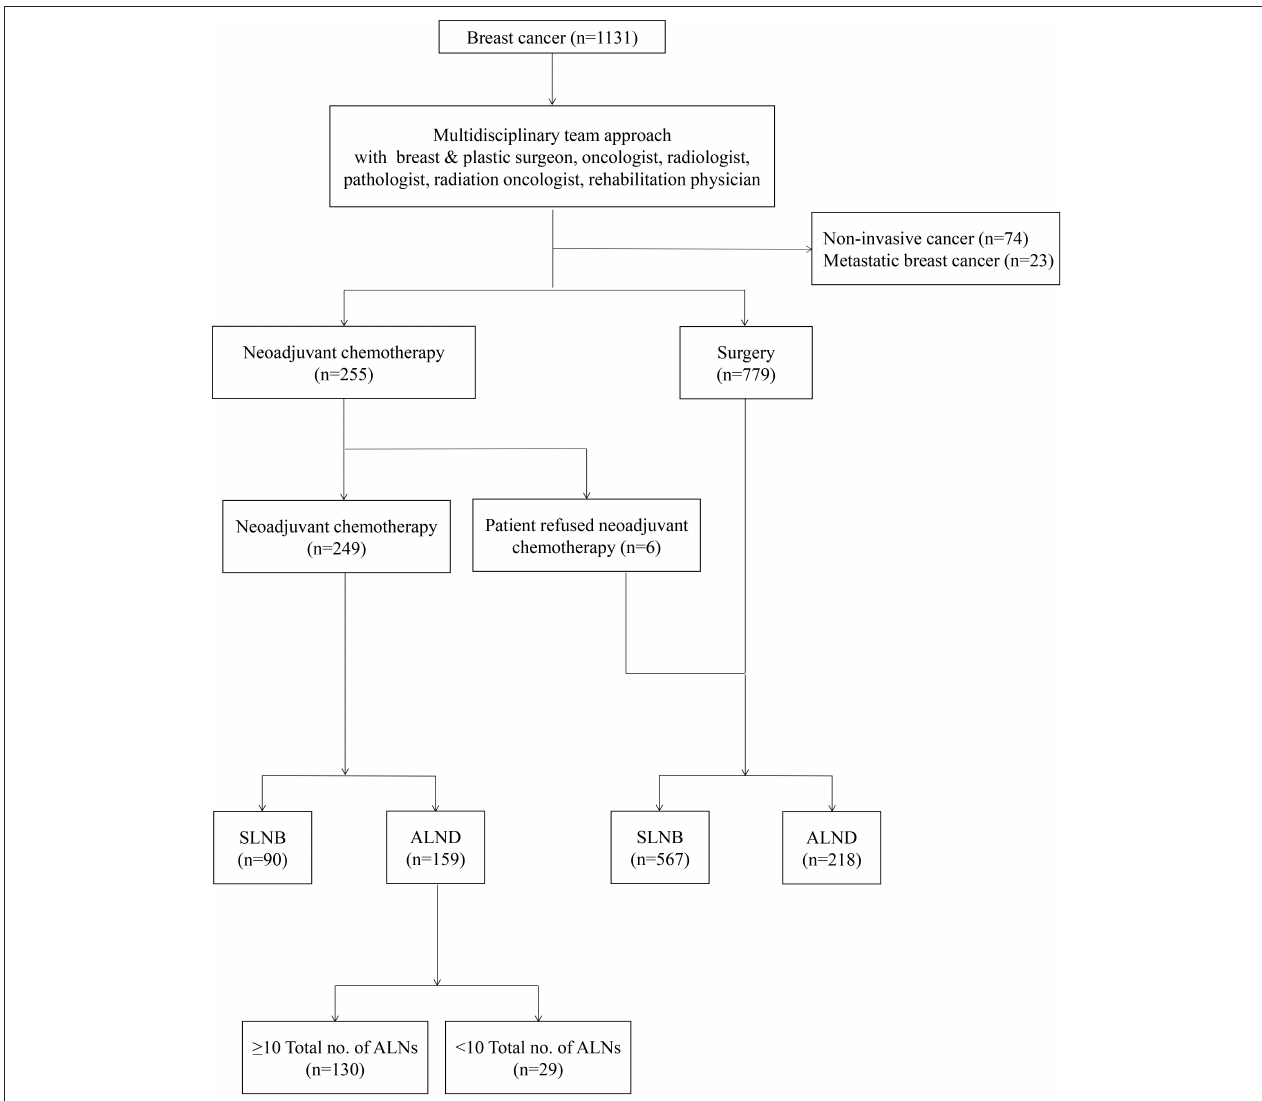
FIGURE 1 | A flow chart showing management of breast cancer with a multidisciplinary team approach. SLNB, Sentinel lymph nodes biopsy; ALND, axillary lymph nodes